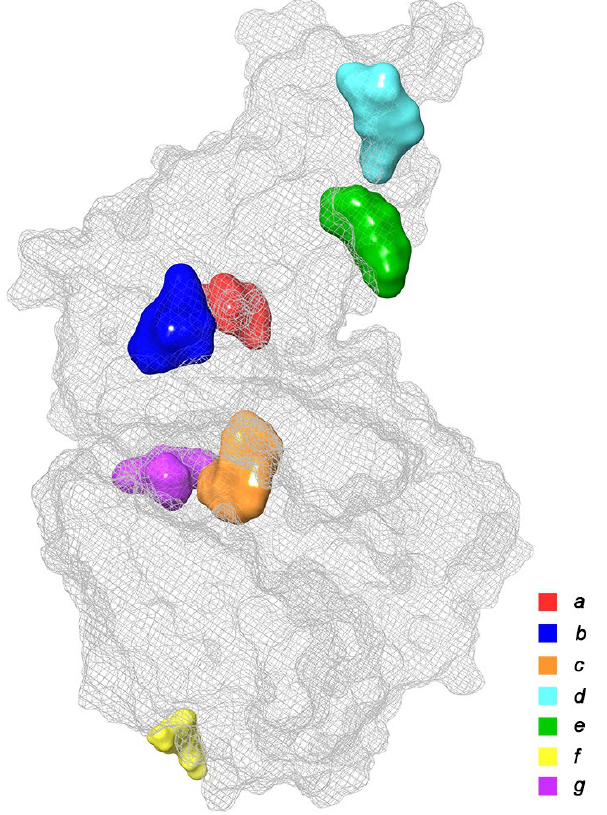
Figure 3. Main binding domains of potential ligands to receptors RBD и ACE2 (based on data provided in Refs. [20–65]. Table 1. Potential inhibitors of the basic domains a – g of SARS-CoV-2 Spike RBD–ACE2 previously identified by in silico investigations.